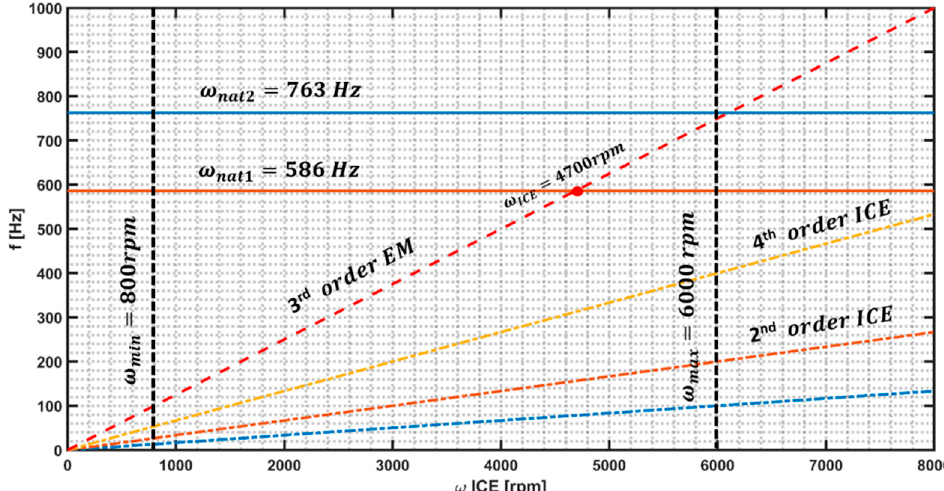
Figure 17. Campbell diagram.